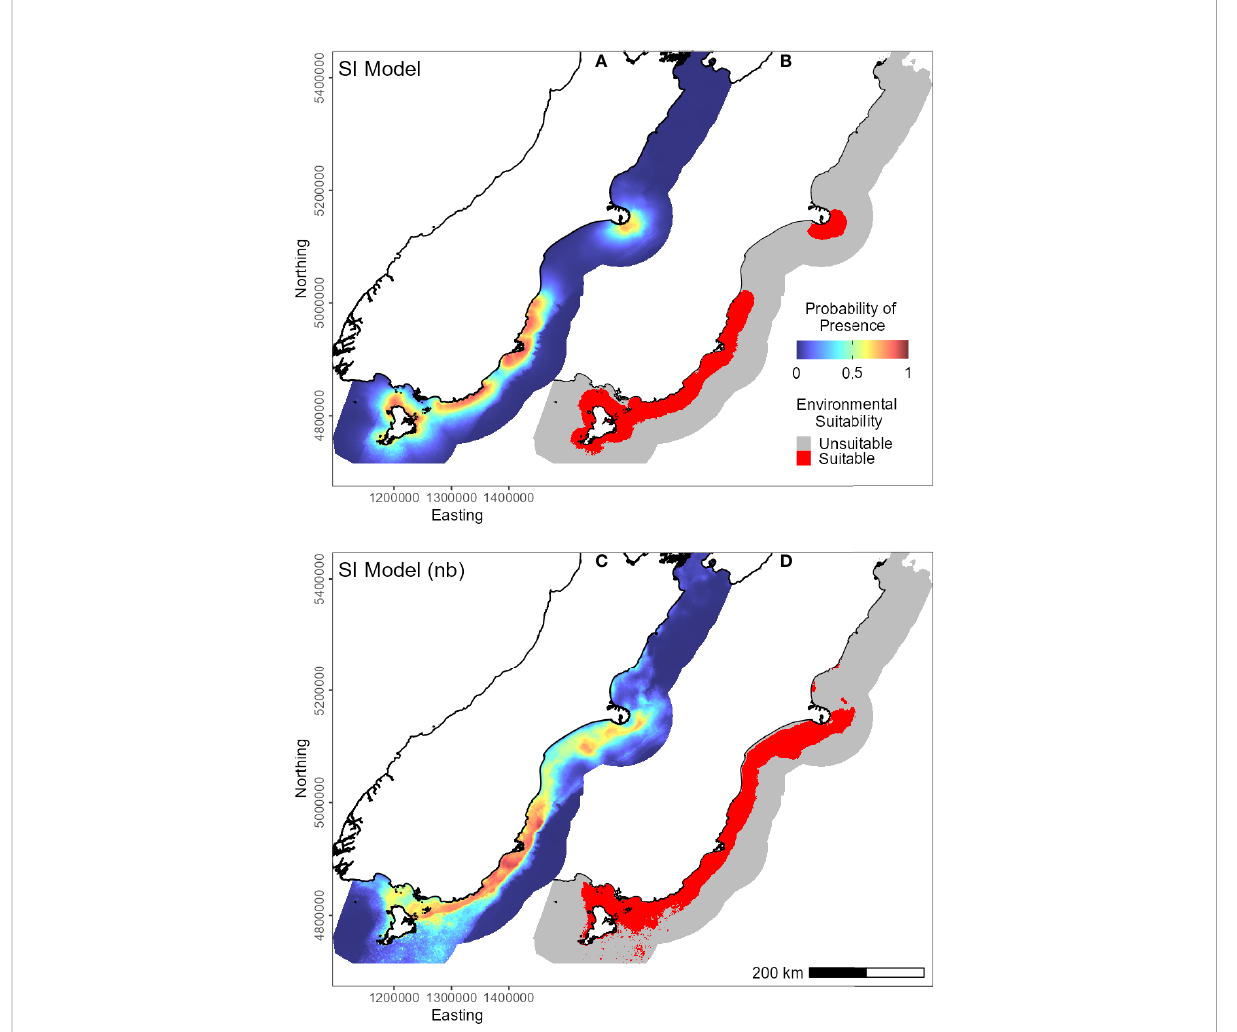
FIGURE 3 Predicted probability of presence (cloglog) of yellow-eyed penguins in New Zealand across their South Island marine range (A, C) . Binary environmental suitability is shown on the right (B, D) , with suitable habitat in red. The top two maps (A, B) include distance to the nearest colony as a predictor variable (SI model), while the bottom maps (C, D) do not include distance (SI model